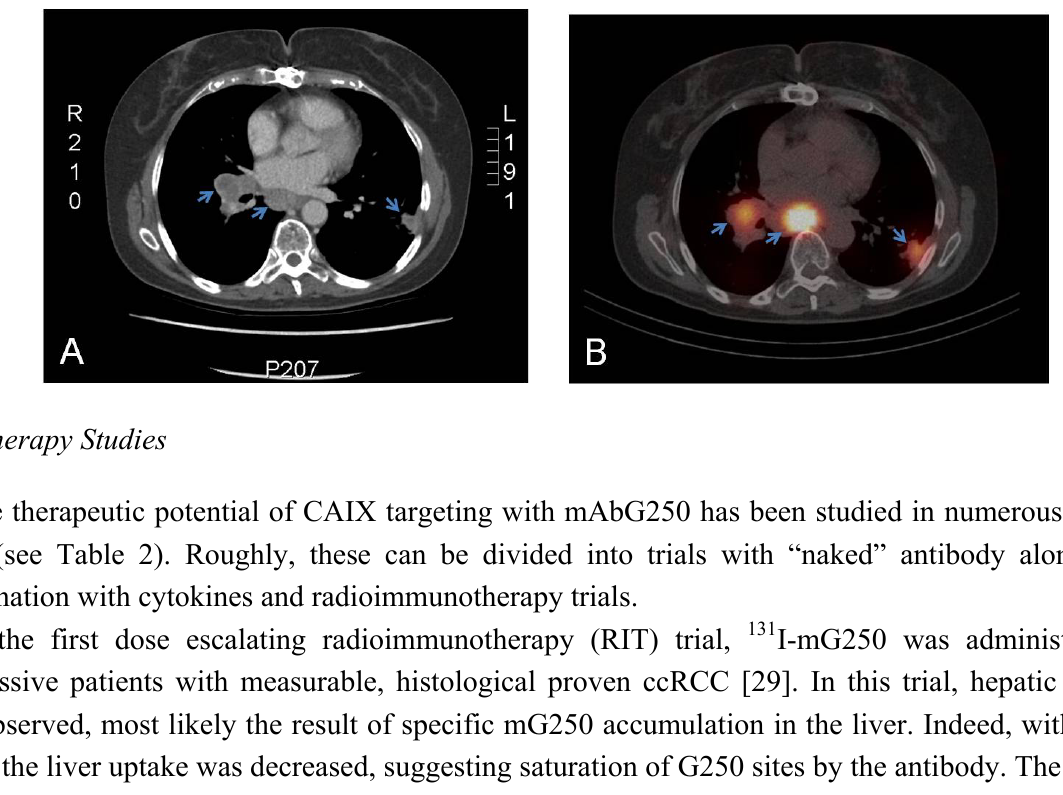
Figure 3. Images of a patient with metastatic RCC. Conventional CT ( A ) and 111 In-girentuximab immunoSPECT ( B ) images of a patient with metastatic ccRCC. Clear and preferential uptake of the radiolabeled antibody was observed in mediastinal and pleural lesions (arrows). The patient was enrolled in the phase II 177 Lu-girentuximab RIT